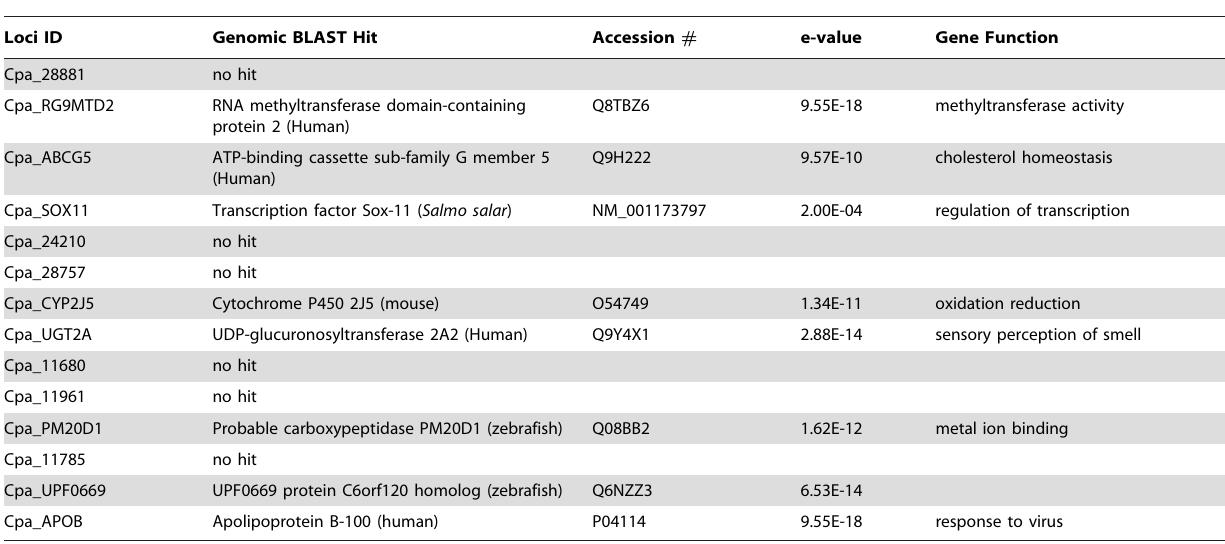
Table 3. Annotation of selected loci based top BLAST hit and GO ontology.